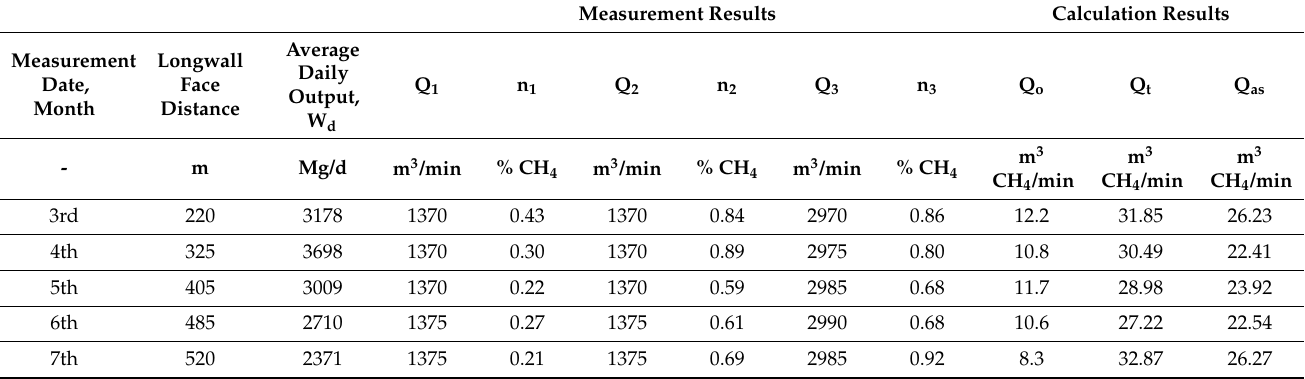
Table 3. Ventilation and methane parameter measurement results, calculated total absolute longwall environment methane emission rate Q t and methane emission rates from overlaying and underlaying strata Q as